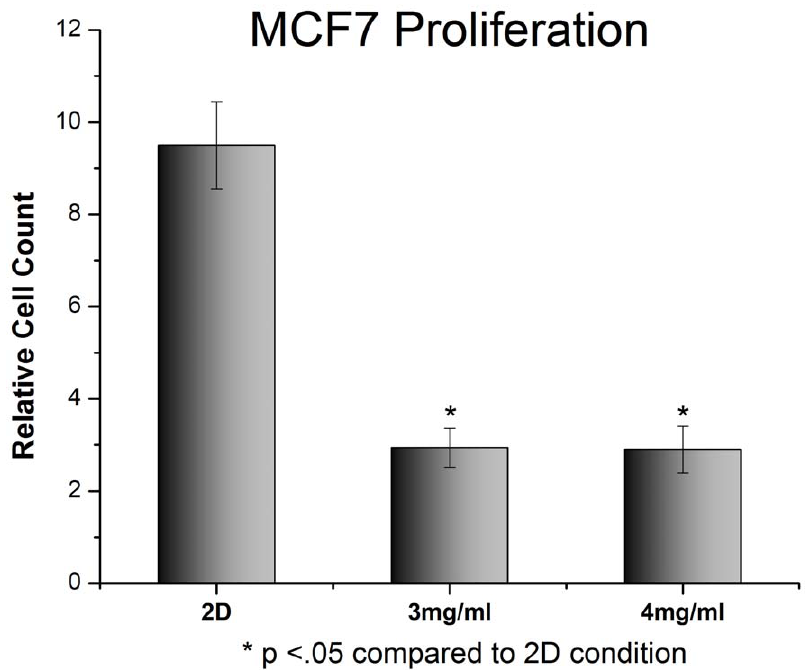
Figure 5. Proliferation of MCF7 cells on standard 2D tissue culture plastic compared to 3D collagen gels. Cells were plated and immediately imaged. 96 hours later the cells were imaged again and the cell population was compared to the initial numbers. Cells in 3D show a dramatic reduction in proliferation. Cells in 2D showed much more aggressive growth, with cell doubling occurring every 30–36 hours. (p , .05 between 2D and 3D samples).